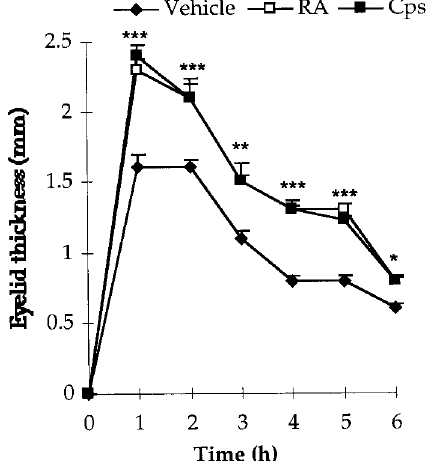
FIG. 3. Histamine-induced oedema of guinea-pig eyelid. Effect of vehicle, ricinoleic acid (RA, 0.9mg/guinea-pig) and capsaicin (Cps, 0.09mg/guinea-pig). Ricinoleic acid, capsai- cin and the vehicle were administered topically 30min before histamine injection. Data are mean ± standard error (SE). n = 5–8 for each group. * p < 0.05; ** p < 0.01; *** p < 0.001 versus vehicle group.